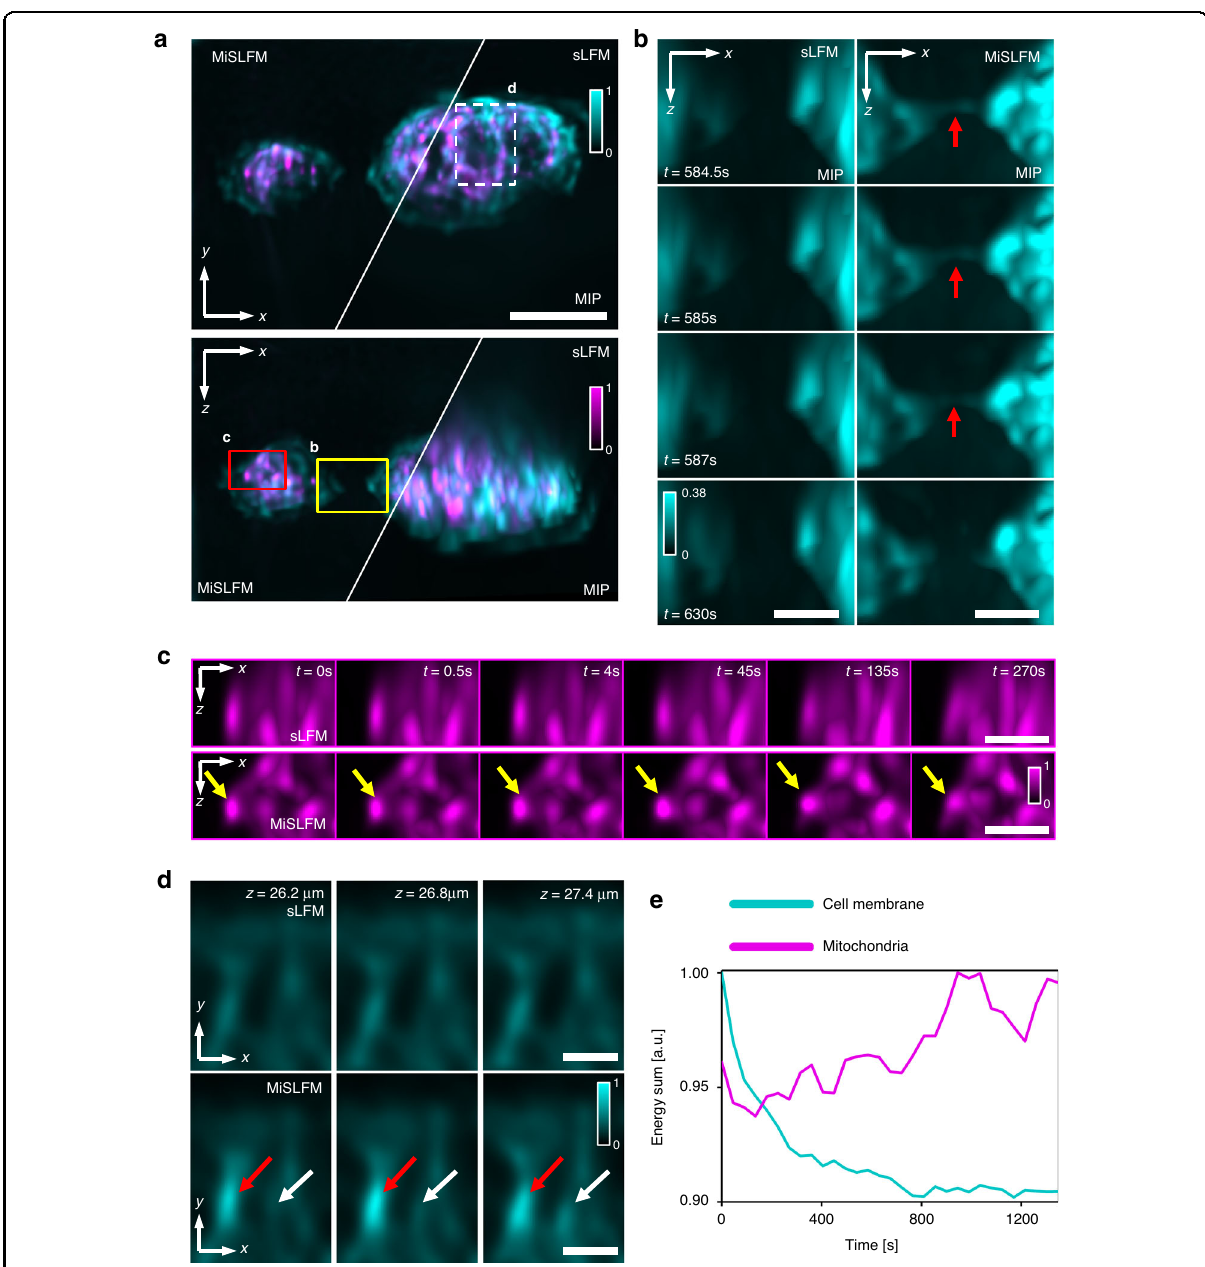
Fig. 2 Two-color volumetric imaging of the membrane and mitochondria of NRK cells. a MIPs of the cell membrane (cyan, 488 nm) and mitochondria (magenta, 561 nm), at a 2-Hz volume rate over 90 µm × 70 µm × 70 µm reconstructed by sLFM and MiSLFM, respectively, under the laser power of 3.95 mW mm − 2 (488 nm) and 1.99 mW mm − 2 (561 nm), demonstrating the obvious axial resolution improvement for MiSLFM under a 40×/0.8NA objective. b Magni fi ed areas marked by yellow boxes in ( a ) of the cell membrane MIP time series by sLFM (left) and MiSLFM (right). Red arrows mark the cell membrane contact of two cells, which is hard to visualize in traditional sLFM and LFM. c Magni fi ed areas marked by red boxes in ( a ) of the mitochondrial MIP time series by sLFM (top) and MiSLFM (bottom). Yellow arrows mark the mitochondria. d Magni fi ed slices marked by white dashed boxes in ( a ) at z = 26.2, 26.8, and 27.4 µm by sLFM (top) and MiSLFM (bottom). Red and white arrows mark locations with obvious intensity changes to show the improved capability of optical sectioning. e Normalized temporal traces of the whole two-color volumes in ( a ). No photobleaching in mitochondria and only 10% photobleaching in the cell membrane were observed over 20 min. Scale bars in a is 20 µm, in b – d are 5